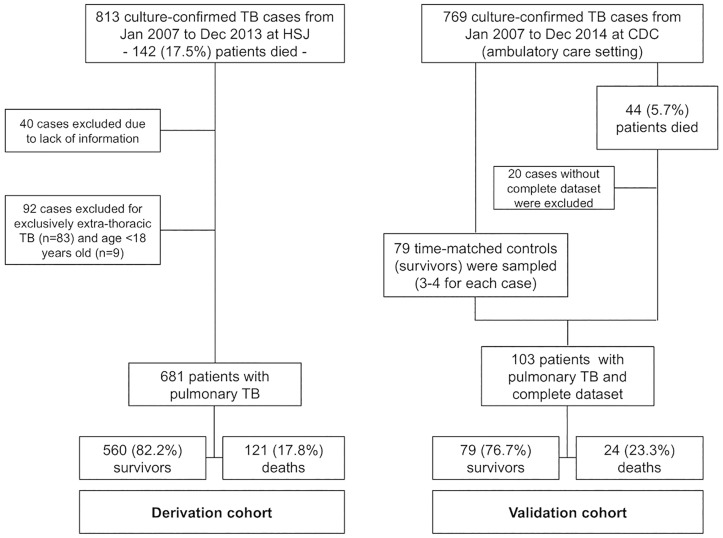
Flow chart for the selection of the participating patients, according to the STROBE guidelines.HSJ—Hospital São João, Porto, Portugal; CDC—Chest Disease Centre (ambulatory care), Vila Nova de Gaia, Portugal.